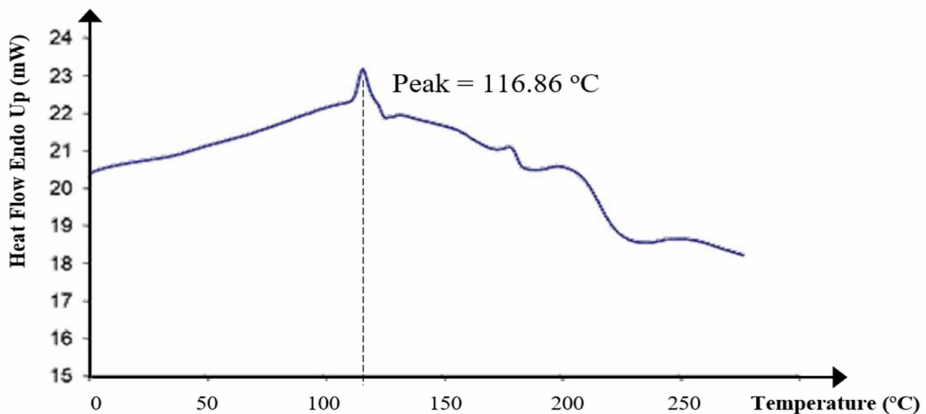
Figure 8. Thermal behavior from differential scanning calorimetry of KWSP.